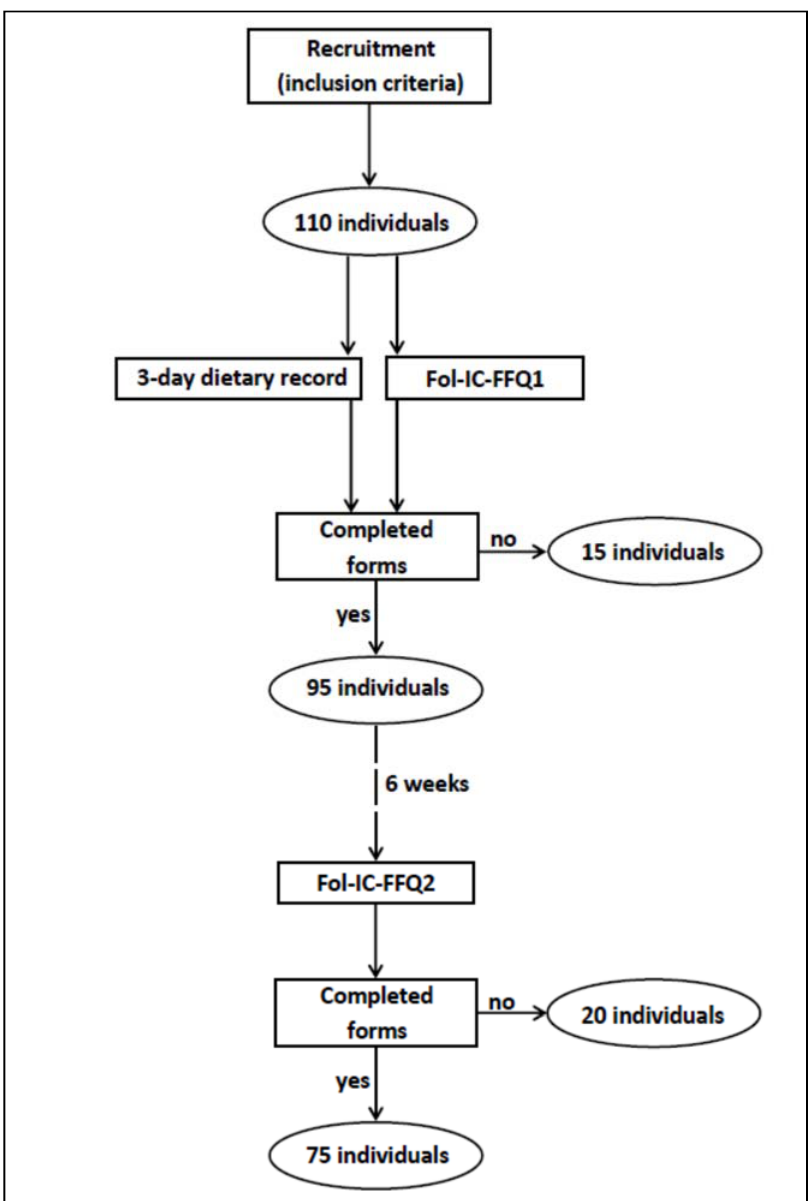
Figure 1. The design of the study.